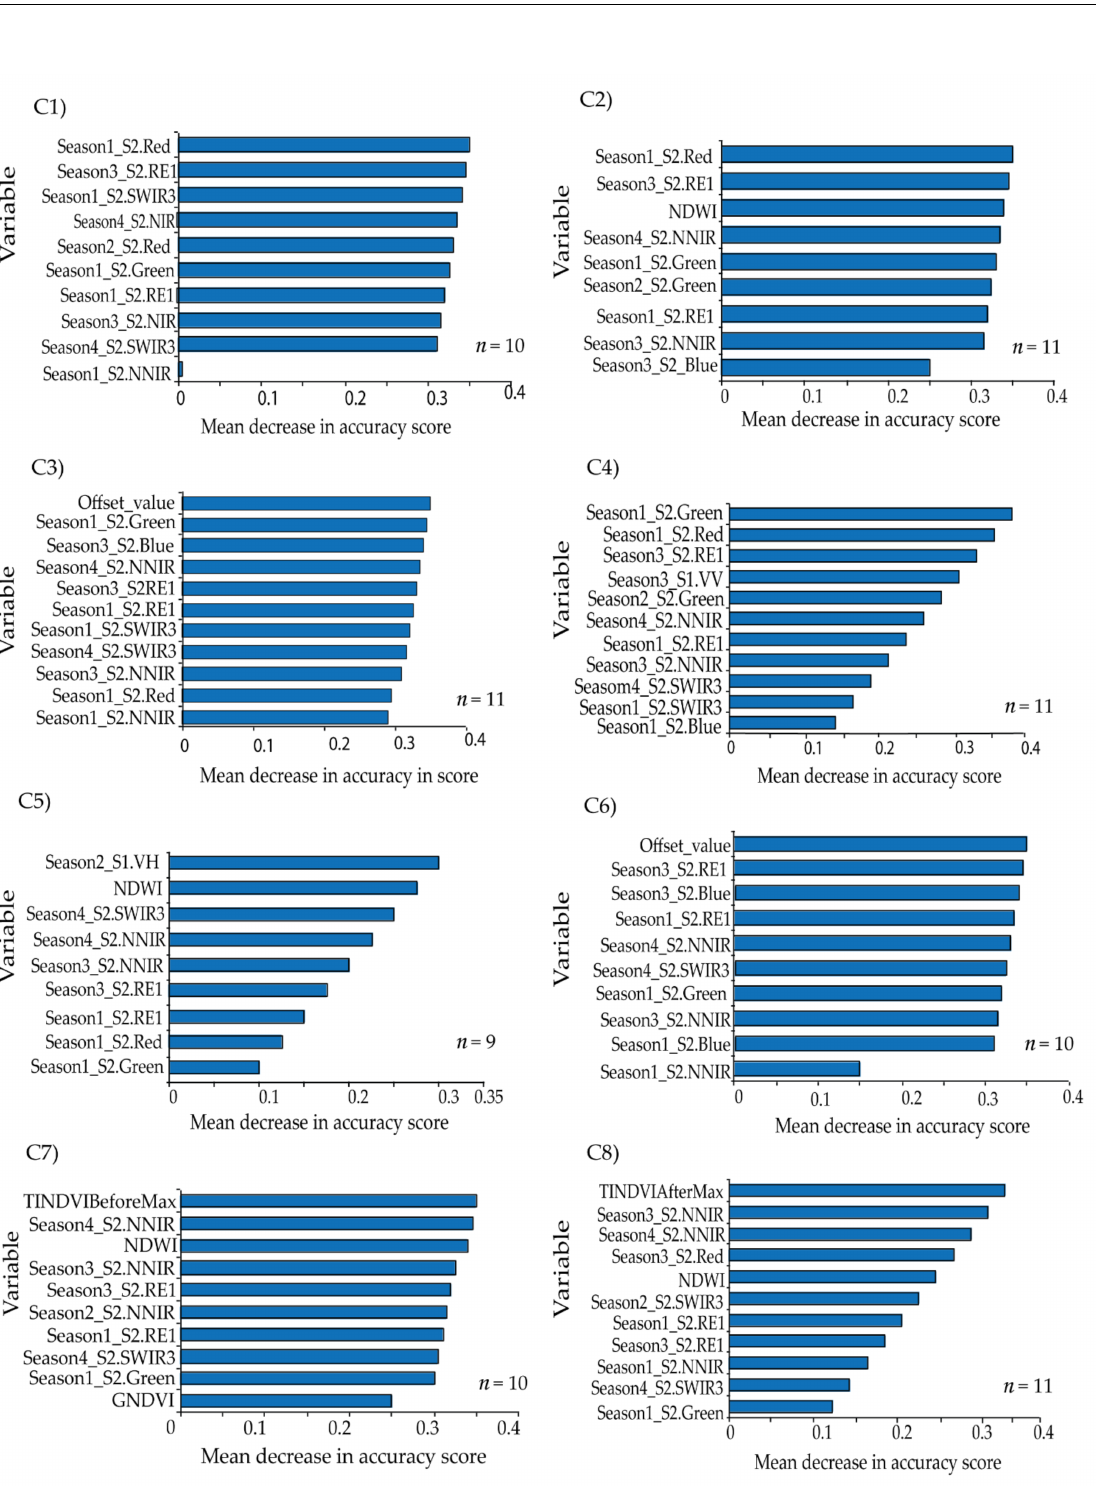
Figure 3. Guided regularized random forest- selected variables in each of the eight cropping pattern classification scenarios C1 to C8. C1 = Sentinel-2 reflectance bands, i.e., S2 bands; C2 = S2 bands and vegetation indices (VIs), i.e., S2 bands and VIs; C3 = S2 bands and vegetation phenology (VP), i.e., S2 bands and VP; C4 = S2 bands and Sentinel-1 (S1) backscatter data, i.e., S2 bands and S1; C5 = S2 bands, VIs and S1; C6 = S2 bands, VP and S1; C7 = S2 bands, VP and VIs; C8 = S2 bands, VIs, VP and S1; NDWI = normalized difference water index; GNDVI = green normalized difference vegetation index; NIR = near infrared band 8 of S2; RE1= vegetation red edge band 5 of S2; SWIR3 = short wave infrared band 11 of S2; NNIR = narrow near infrared band 8a of S2; VV = vertical transmit vertical receive of S1; VH = the vertical transmit horizontal receive of S1; TINDVIBeforeMax = area under the NDVI curve between onset and max_value of VP variables and TINDVIAfterMax = area under the NDVI curve between max_value and offset of VP